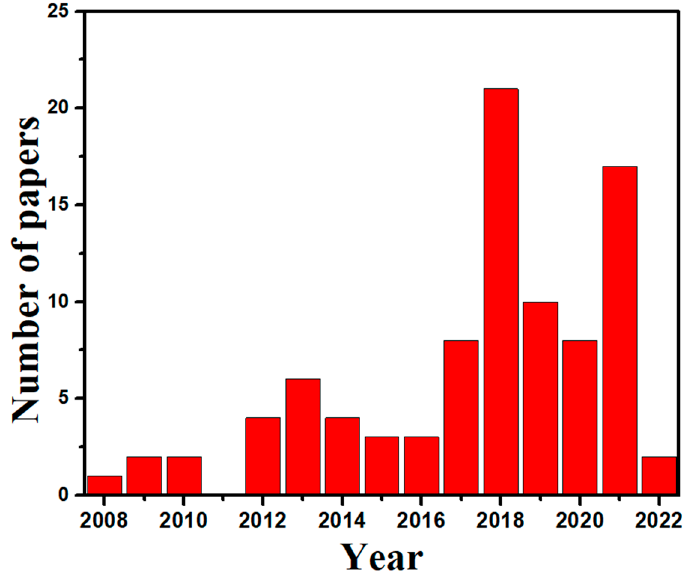
Figure 1. Histogram shows the proportion of papers published on green techniques for TiO 2 NPs .